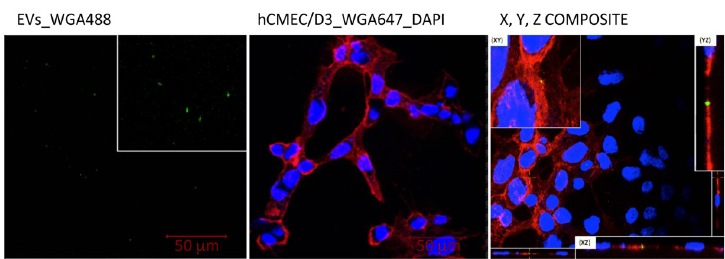
Fig 2. EV uptake in endothelial cells (hCMC/D3) 15 min post addition of EVs the co-localization of EVs in the hCMEC/D3 cell line were visualized by confocal microscopy (Nikon A1). EVs were stained with WGA 488 (green), nuclei with DAPI (Blue), cell membranes glyco-proteins with WGA640 (red). The images were analyzed by NIS element viewer version 4.40.00. Scale bare 50 μ m.